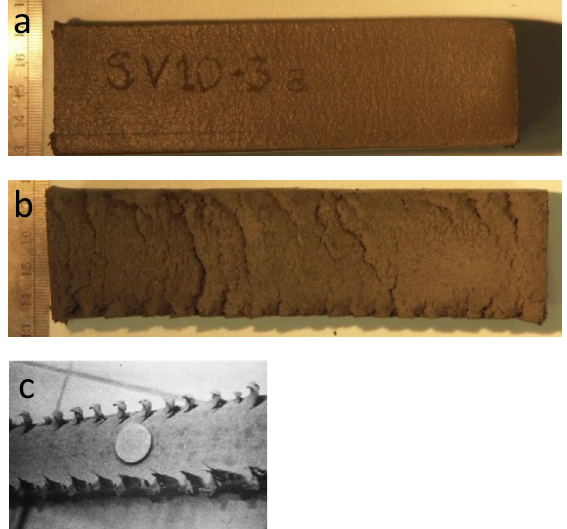
Figure 5. Example of extrudates a) with good surface quality; b) with surface ruptures and; c)